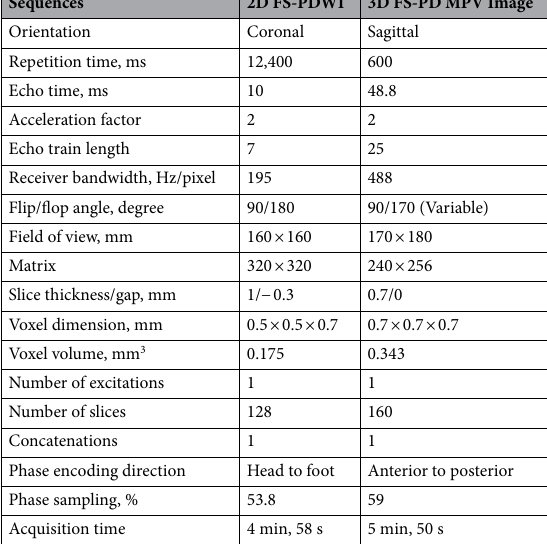
Table 1. MR pulse sequence protocol. MR indicates magnetic resonance, 2D 2-dimensional, FS-PDWI fat saturated-proton density weighted image, 3D 3-dimensional, FS-PD MPV fat saturated-proton density multi planar